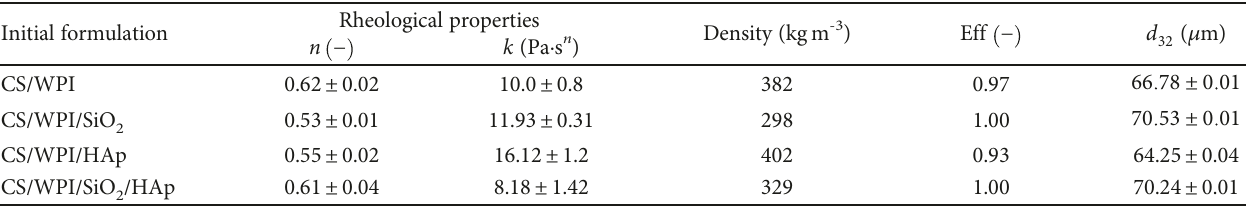
Table 4: Rheological properties, density, Eff , and d and N = 600rpm ).